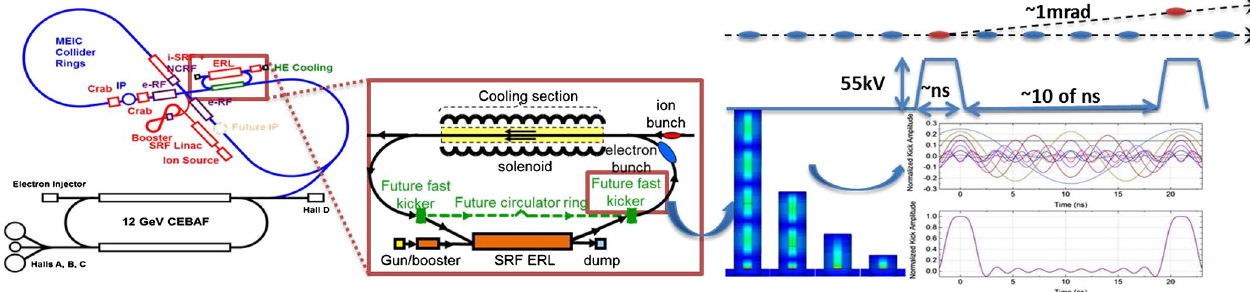
FIG. 1. The scheme of the ERL-based electron circulator cooler ring in the proposed JLEIC and the design concept of an ultrafast kicker with multiple harmonic modes generated by a group of QWRs.